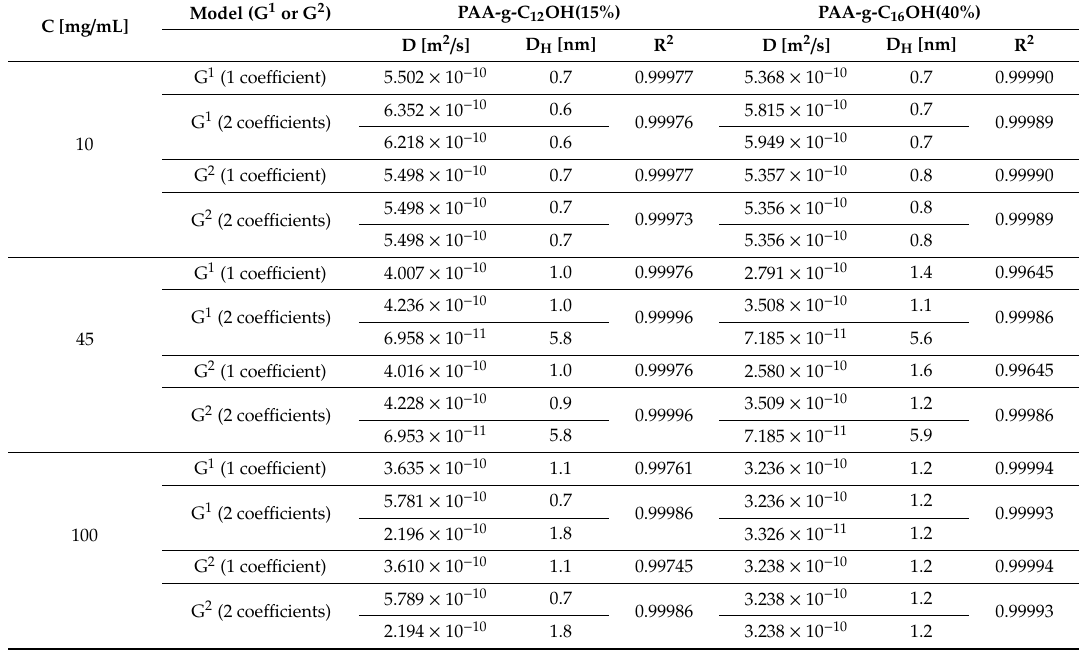
Table 1. Determination of di ff usion coe ffi cients (D) and hydrodynamic diameters (D H ) by fitting data to appropriate models: G 1 (intensity versus linear gradient) or G 2 (intensity versus square